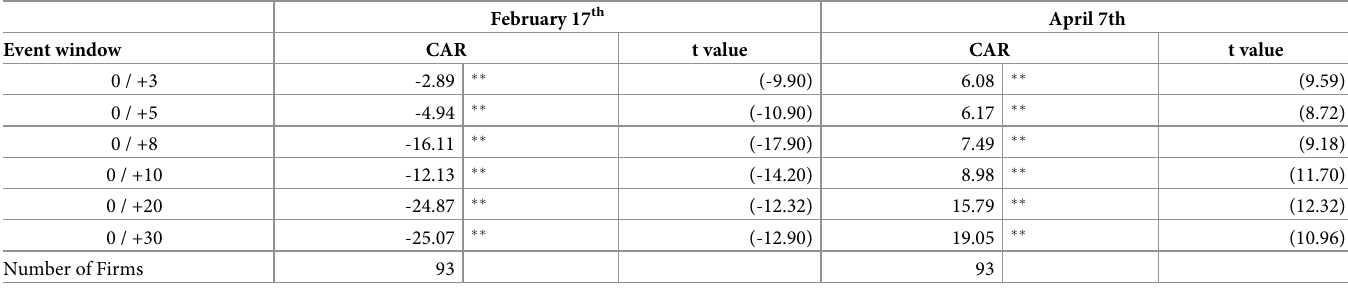
Table 2. Results of CAR (cumulative abnormal return).